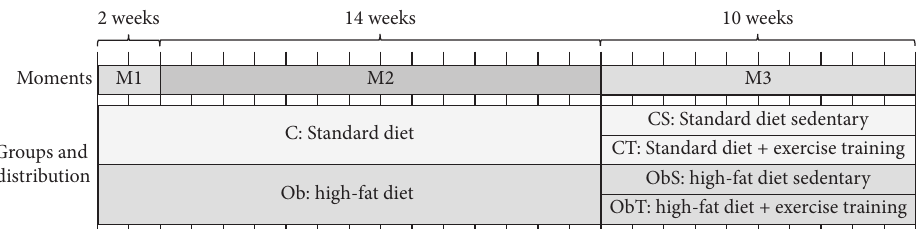
Figure 1: Schematic representation of the experimental design. Moment 1 (M1): 2 weeks for the induction period to obesity. After induction, the animals were kept under the same conditions for 14 consecutive weeks for maintenance of obesity, which was classified as moment 2 (M2). The training protocol, carried out for 10 weeks, determined moment 3